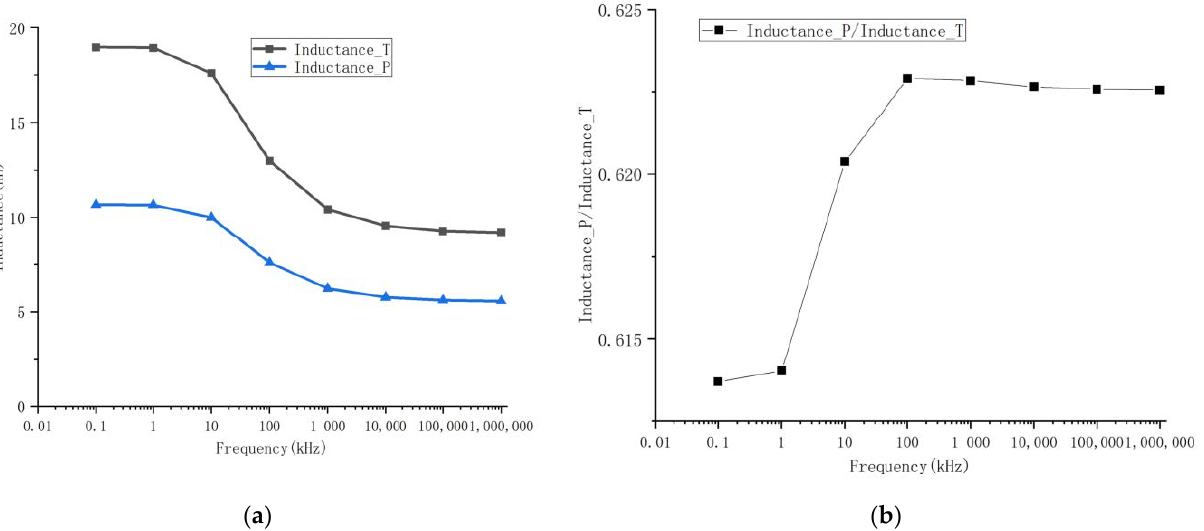
Figure 10. ( a ) The parasitic inductance of the proposed and traditional bias circuits. ( b ) The ratio of the parasitic inductance of the proposed bias circuit to that of the traditional bias circuit as a function of frequency.